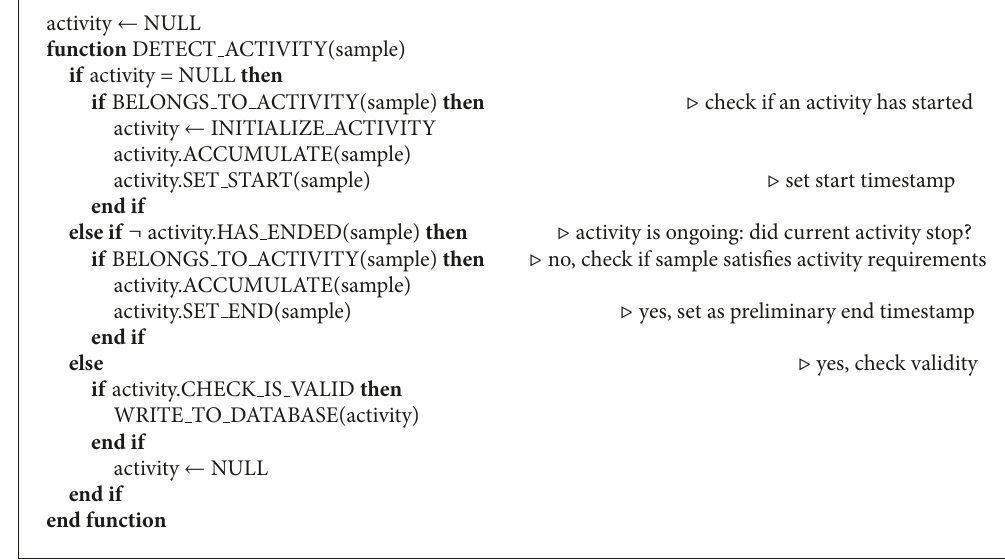
Algorithm 1: Activity